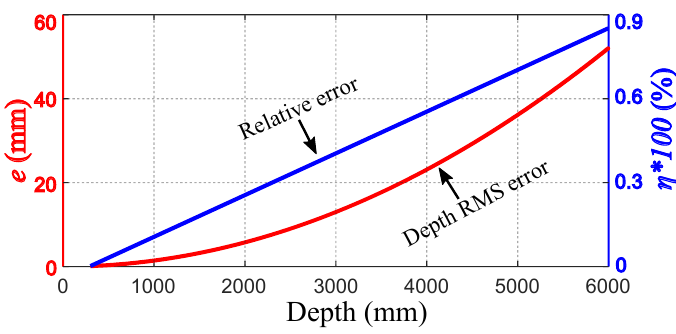
Figure 4. The depth RMS error and relative